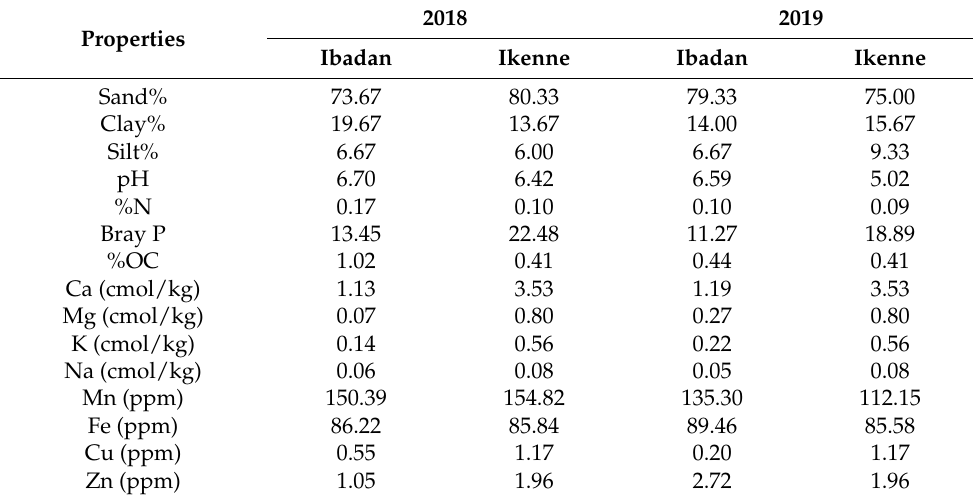
Table 3. Soil properties at the beginning of the experiment for individual locations and